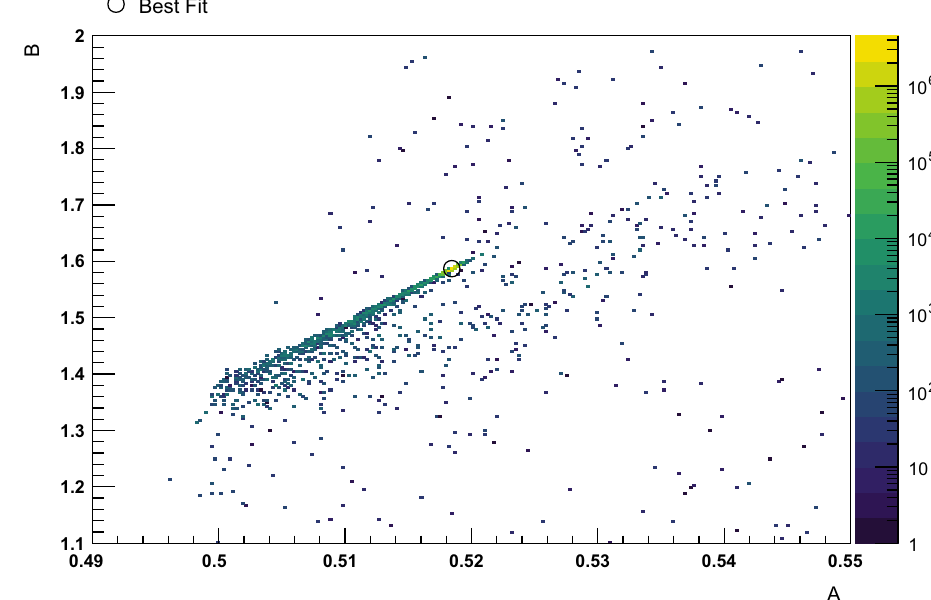
Fig. 7 Probability density of the AB fit as a function of the B and A parameters. The legend shows the probability scale in an arbitrary units